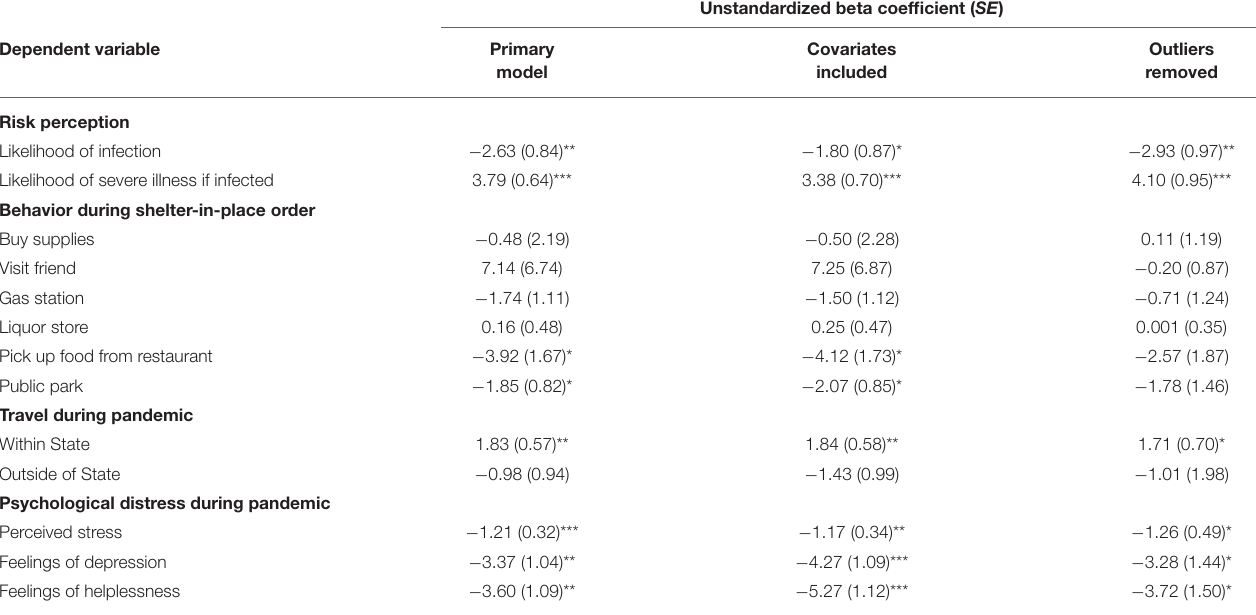
Unstandardized beta coefficient ( SE )